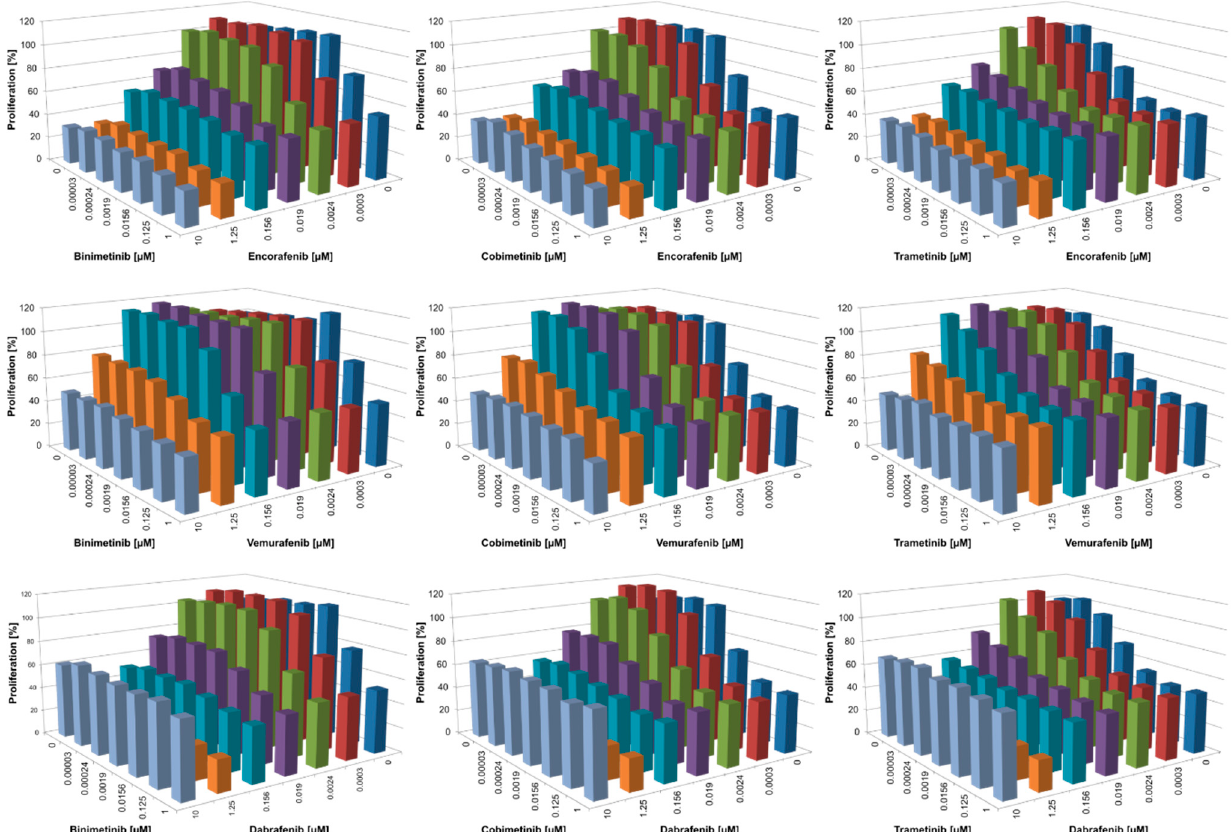
Figure 4. Inhibition of proliferation of WM3734 (BRAF mut ) after treatment for 72 h with single or combined BRAFi/MEKi (serial dilutions 1:8); n ≥ 3; for simplicity, the standard deviation and significance are not shown. Significance from these data is displayed in Figures S2 and S3. List of p -values can be found in Tables S5 and S6.